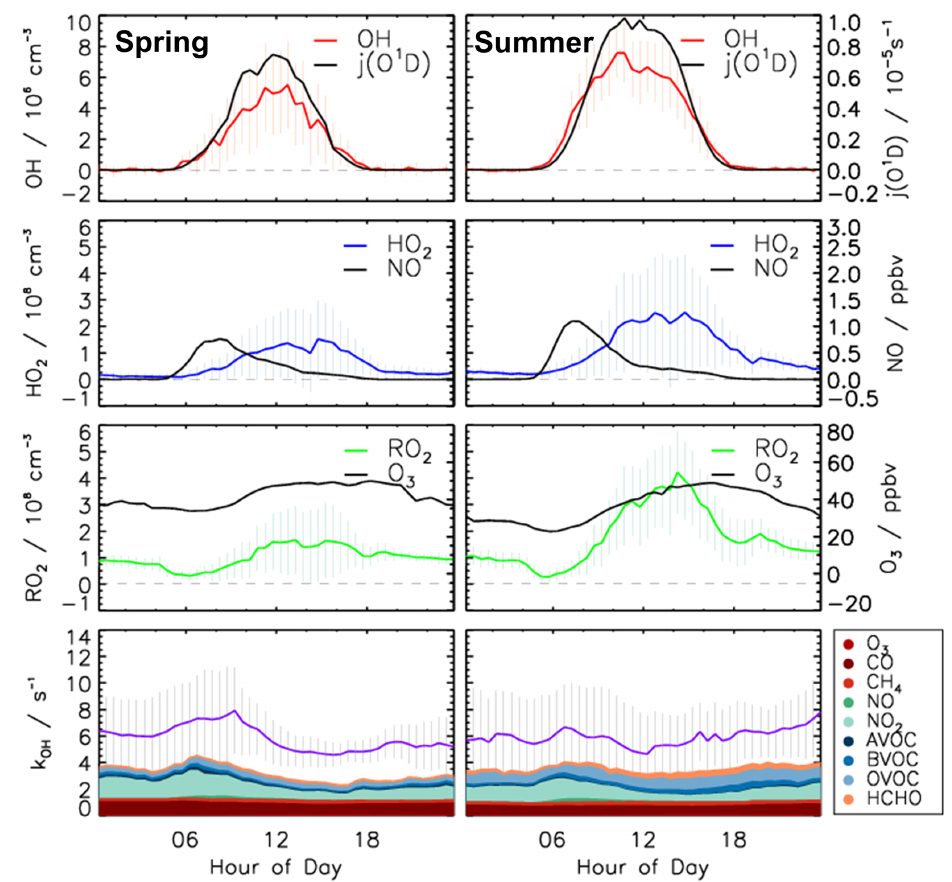
, NO, and O 3 measured in the spring and summer periods of 1 D